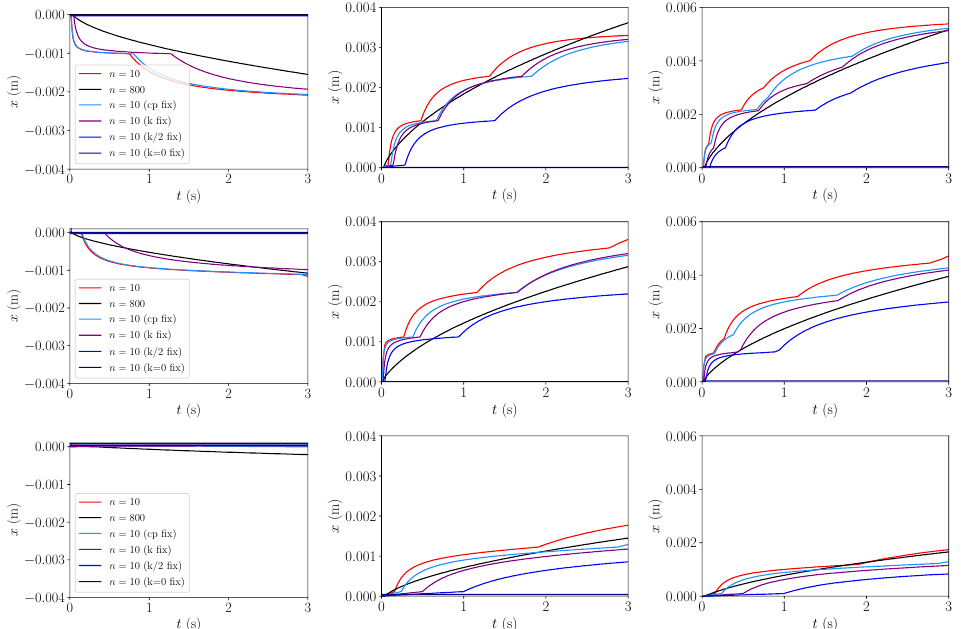
Figure 20. Plot of the movement of the temperature curves now including the results where fixes for the thermal conductivity and isobaric heat capacity were used. The left column of plots tracks the x position of a certain lower temperature threshold, from top to bottom the temperature thresholds were T = 100.1,101,120 . The middle column of plots tracks the x position where a certain high { } temperature threshold, from top to bottom the temperature thresholds were T = The far right column is then the difference between the lower and higher temperature thresholds. The plots were scaled using the initial value so that the plots start at the